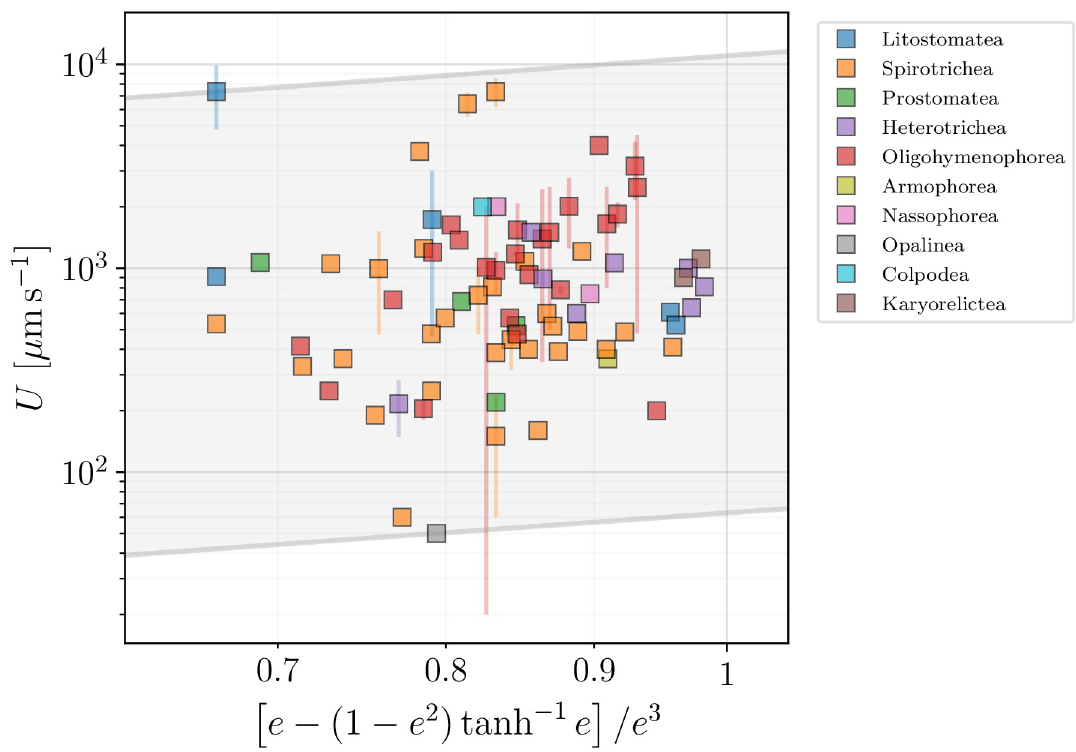
Fig 23. Reported swimming speeds from our database U plotted against the geometric factor from Eq (45) for the constant-flow model (C). The data can be used to estimate the range of effective surface velocities to be in the range from 63.0 μ m s − 1 to 1.10 10 4 μ m s − 1 , in the grey shaded area. Colours allow to distinguish different taxonomic